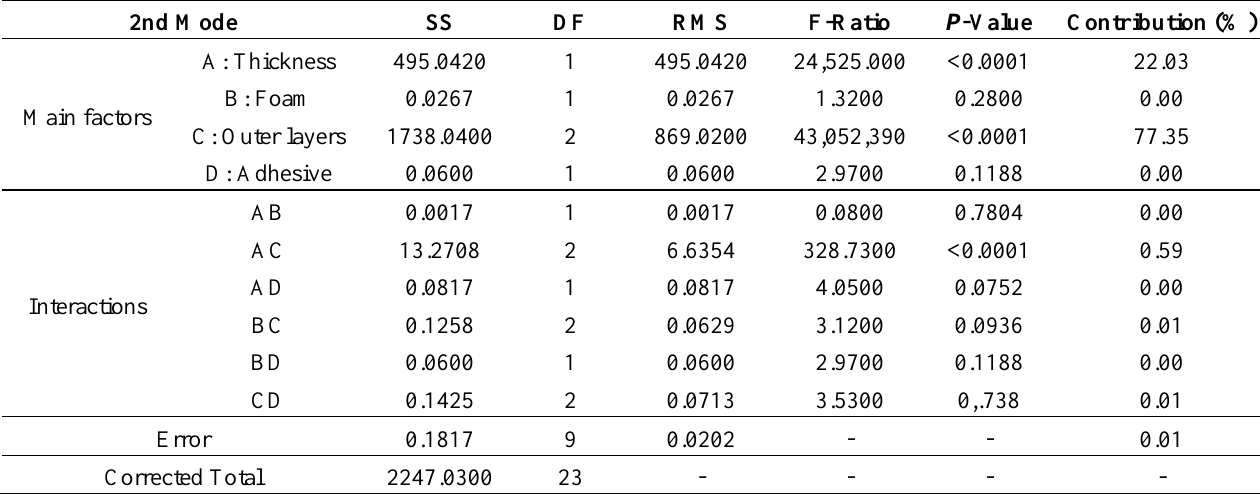
Table 7. 2nd Mode: Analysis of